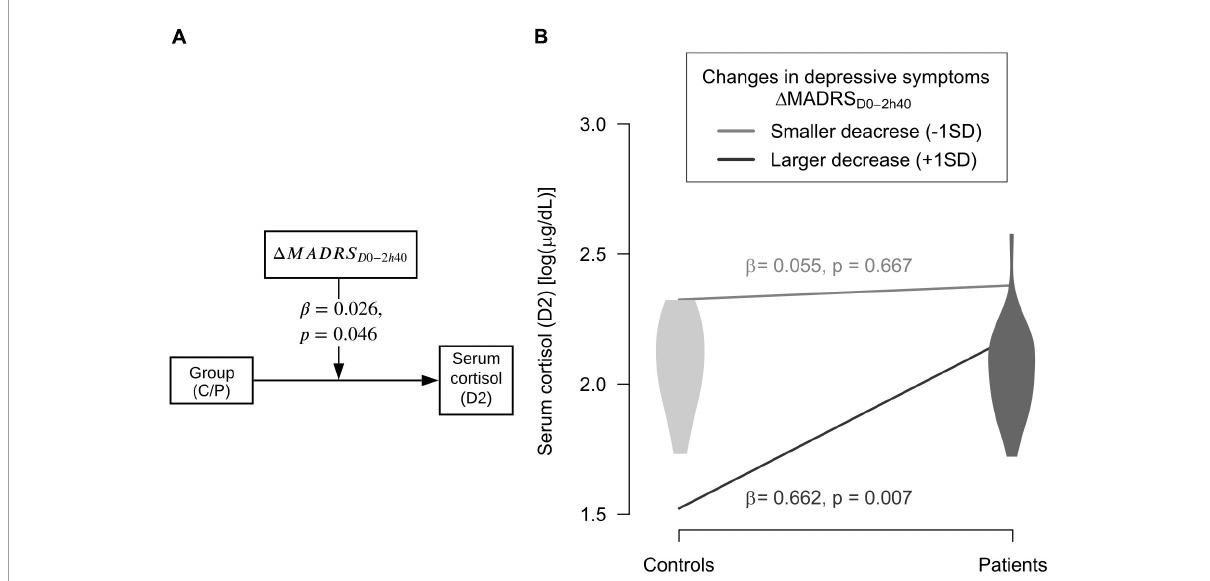
FIGURE2 Moderator of ayahuasca antidepressant action. (A) Changes in depressive symptoms between baseline and 2 h40 after ayahuasca intake ( (cid:49) MADRS D0 − 2h40 ) moderated the significant relation between groups (C = controls; P = patients) and serum cortisol levels at D2 (2 days after dosing). (B) Larger decreases in depressive symptoms moderated higher serum cortisol levels of patients at D2, but not for controls. Dark gray line and violin plot mean statistically significant interaction ( p ≤ 0 . 05); light gray line and violin plot mean not statistically significant